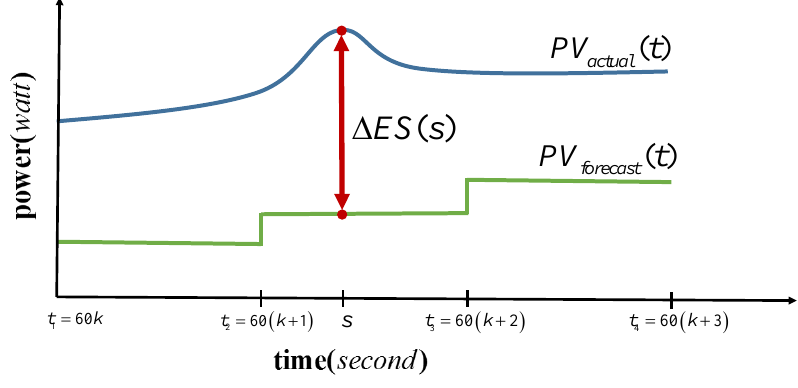
Figure 4. Real-time actual and forecast